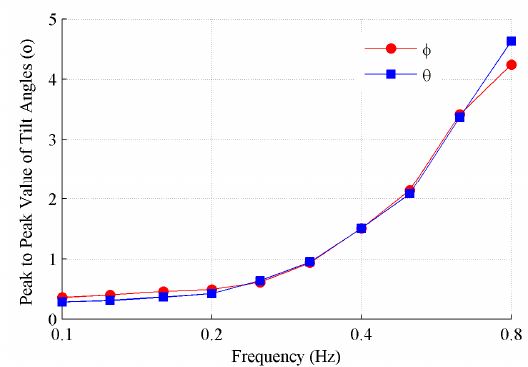
Figure 12. Peak-to-peak values of the tilt angles caused by cross-coupling.